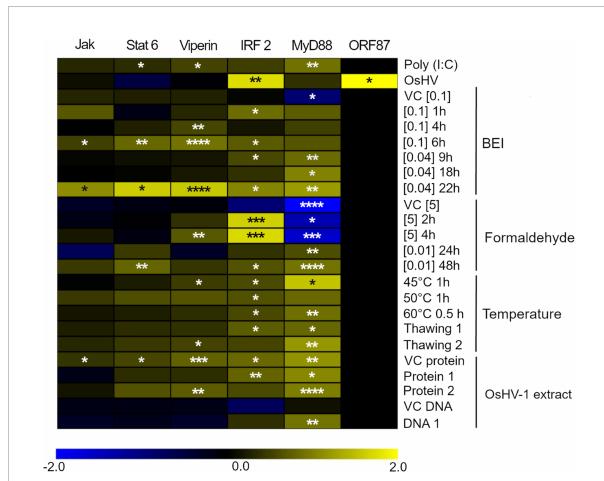
FIGURE 4 Heatmap focusing on the expression of 5 genes related to the innate immune response in Crassostrea gigas and ORF87, an OsHV- 1 ORF expressed early after infection. The intensities of the colors indicate the magnitude of the differential expression (log2 fold- change), N = 3 replicates. The fold-changes were calculated by comparing the expression of each gene in hemocytes exposed to Poly (I:C), live infectious OsHV-1, or OsHV-1 inactivated, with its expression in negative control (hemocytes exposed to SSW). Signi fi cance levels are expressed by asterisks: * (p < 0.05), ** (p < 0.01), ***(p < 0.001), **** (p <